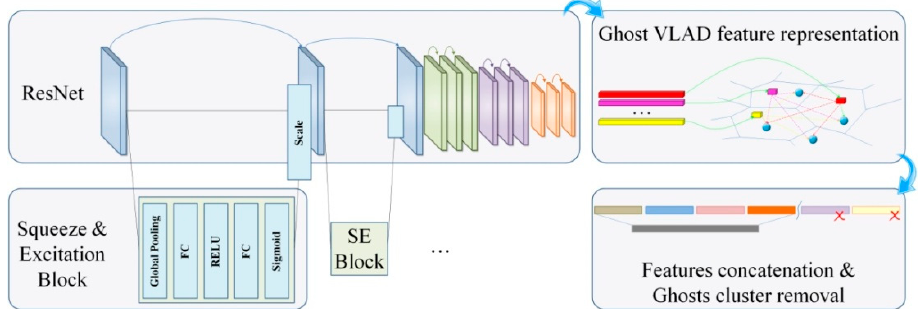
Figure 3. SE ‐ ResNet CNN extension with a GhostVLAD layer for feature aggregation. Figure 3. SE-ResNet CNN extension with a GhostVLAD layer for feature